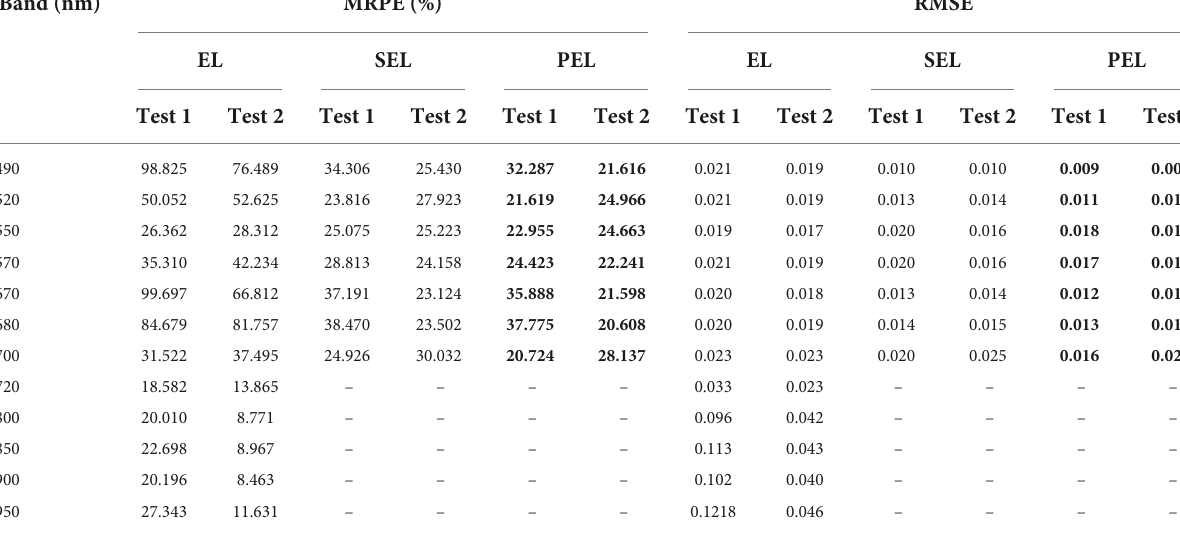
TABLE 2 Statistical results of reflectance accuracy of different RCMs in Test 1 and Test 2.